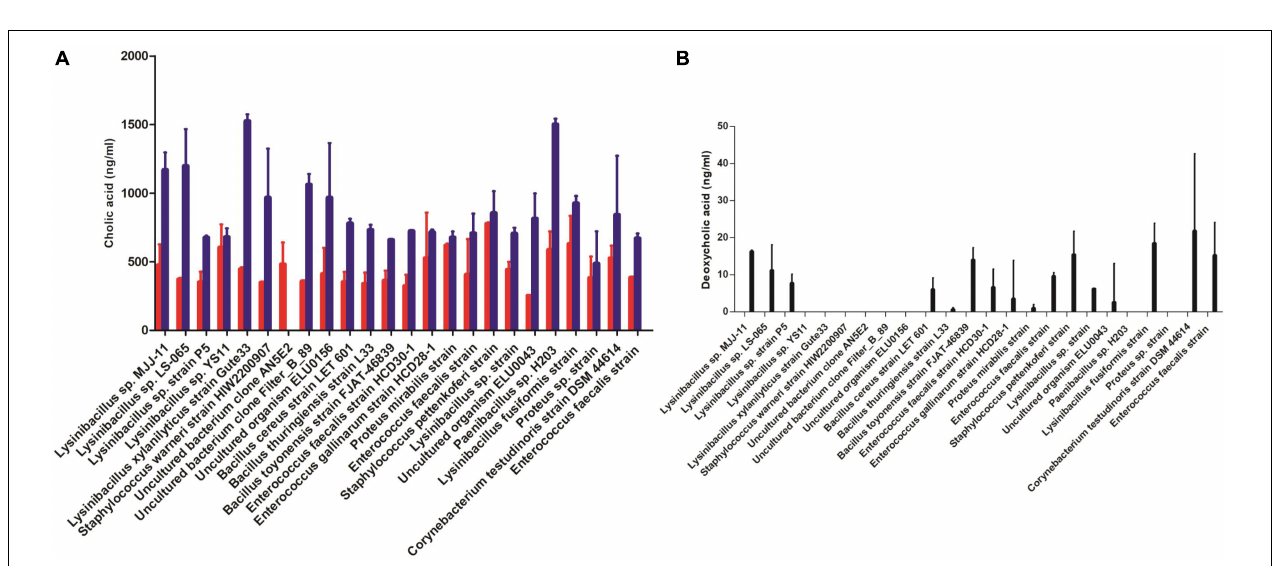
FIGURE 5 | Detection of bile salt metabolism by bile bacterial strains. The concentration of metabolites (A) converted glycocholic acid (GCA) to cholic acid (CA) (red bar), or taurocholic acid (TCA) to CA (blue bar) (B) converted CA to deoxycholic acid (DCA).